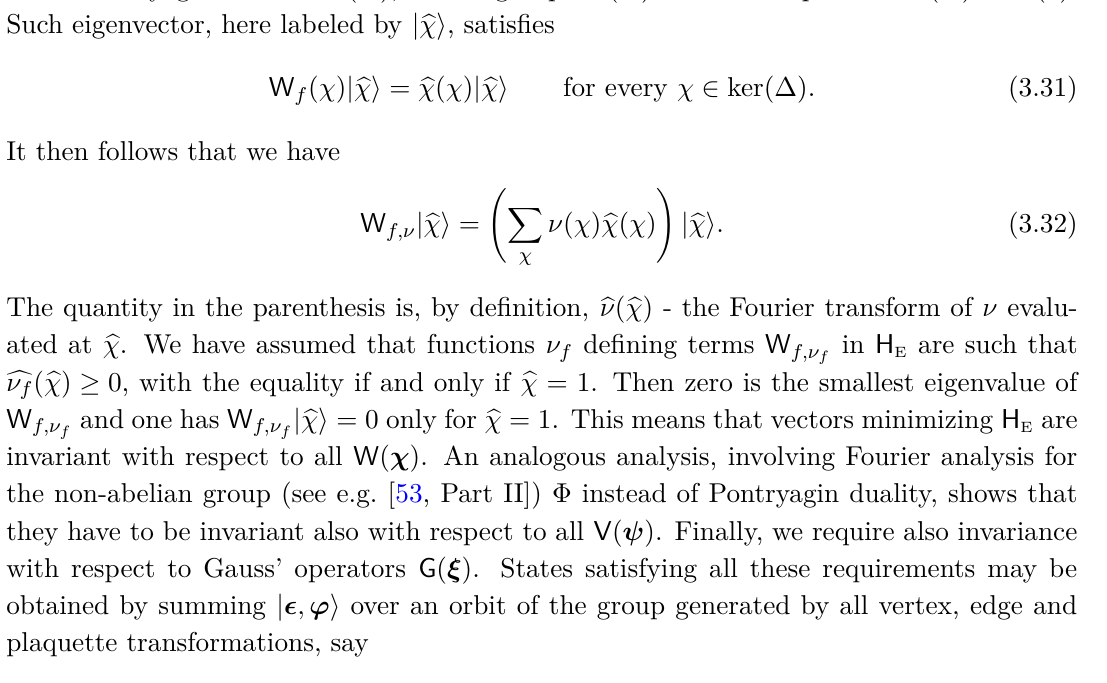
possible to diagonalize all of them at the same time. Eigenvectors are labeled by element of the Pontryagin dual of ker(∆) , i.e. the group \ ker(∆) of homomorphisms ker(∆) → U(1)